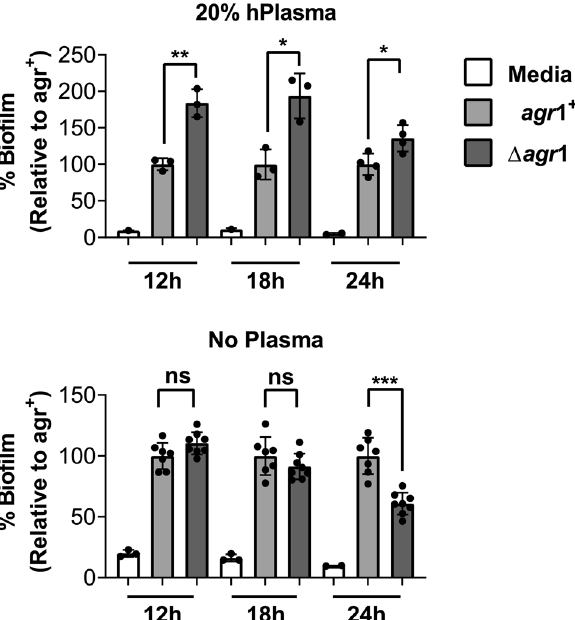
Figure 2. Enhanced S. aureus Δagr1 biofilm formation in vitro is most pronounced as biofilm forms. ( a ) Comparison of biofilm development after 12, 18, and 24 h of growth in TNG with 20% human plasma pre- coating (top) or without plasma pre-coating (bottom). 24 h data is re-graphed from Fig. 1 for comparison. This is agr 1 strain is AH1263 and its isogenic deletion mutant is AH1292. Data represent ≥ 3 replicates and are expressed as the mean ± SD and data is normalized to the agr + at each respective time point (*** p < 0.001, **** p < 0.0001, ns = not significant).